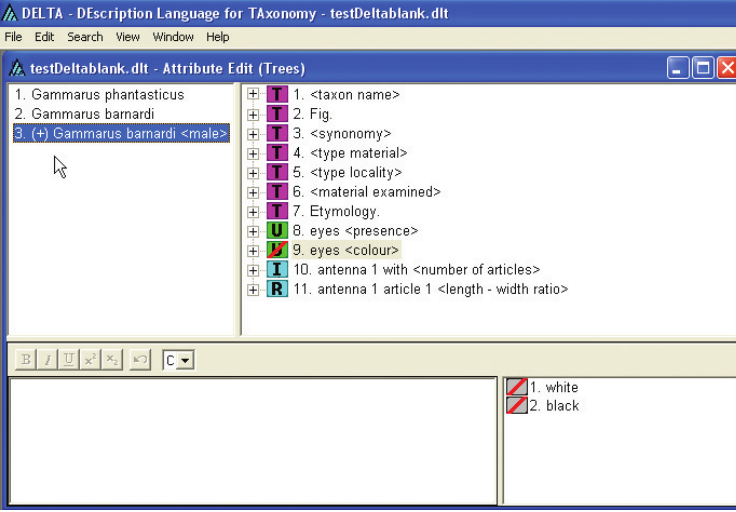
Figure 13. Inserting a taxon that was marked as a variant ( Treat as variant ) in the Taxon editor, indicated by (+) preceding the taxon